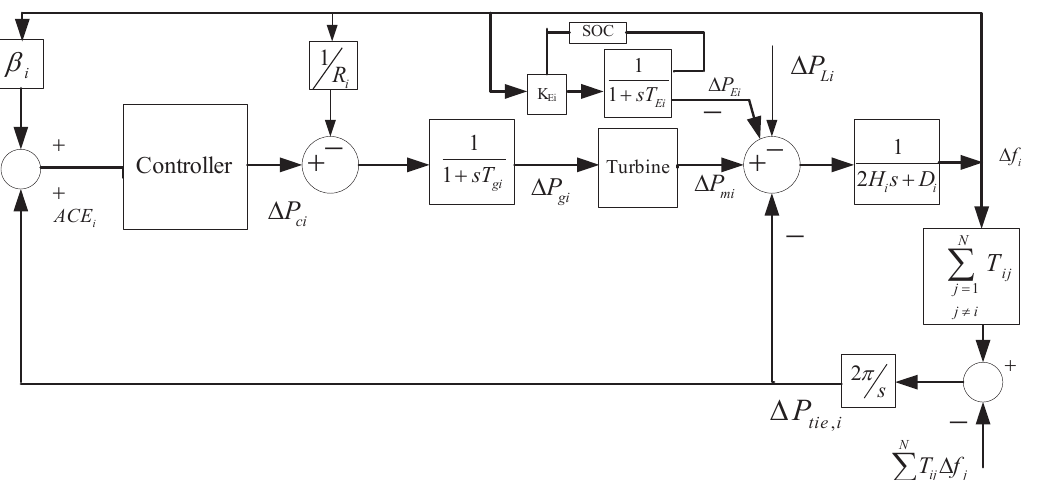
Figure 2. Block diagram of ith control area of V2G system with